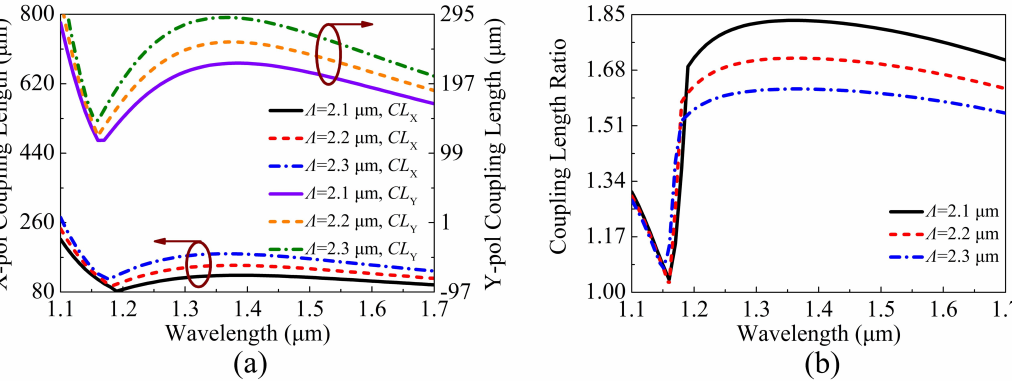
Figure 8. The variations of the ( a ) CL X , CL Y , and ( b ) CLR of the proposed V-DC-PCF PBS for different Λ .